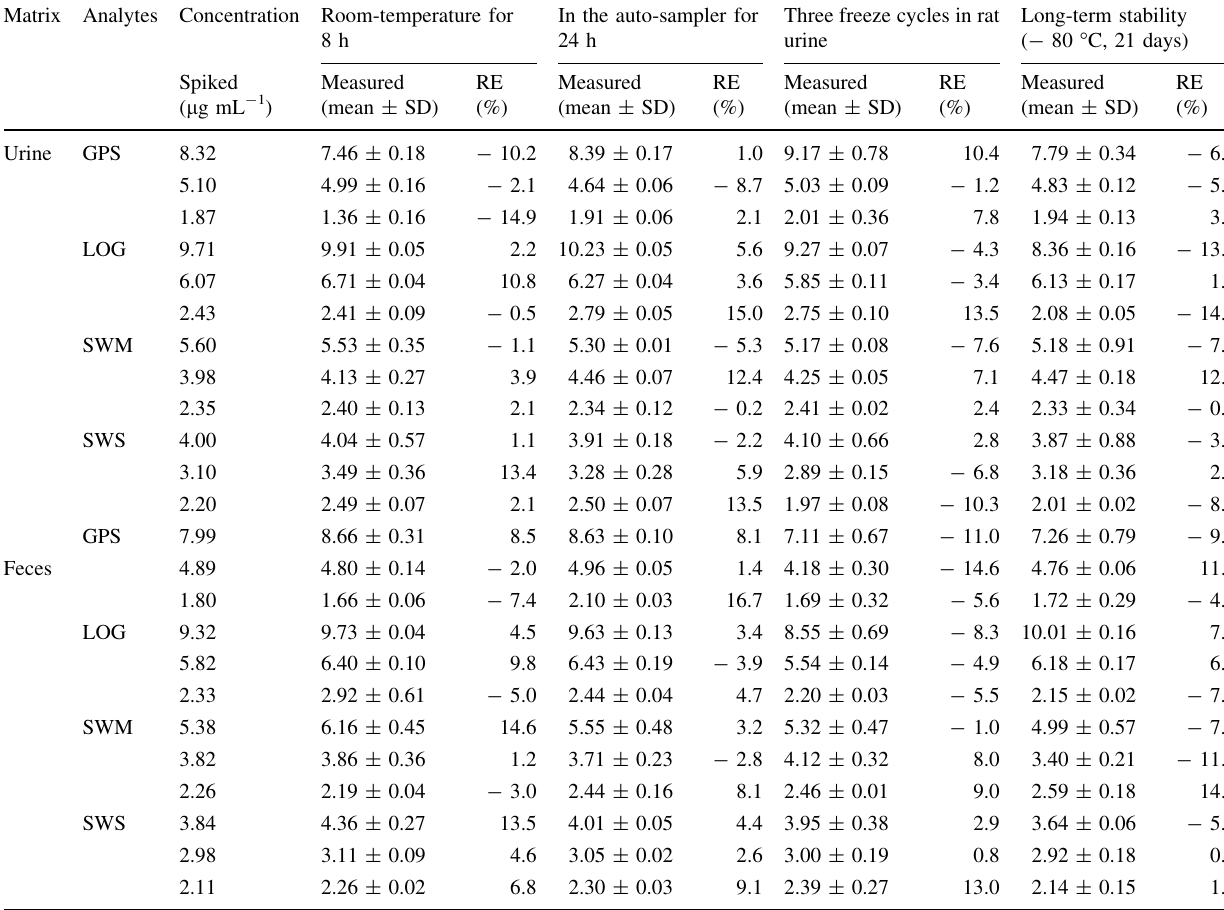
Table 5 Stability of four analytes in urine and feces samples based on ATLD algorithm Matrix Analytes Concentration Room-temperature for